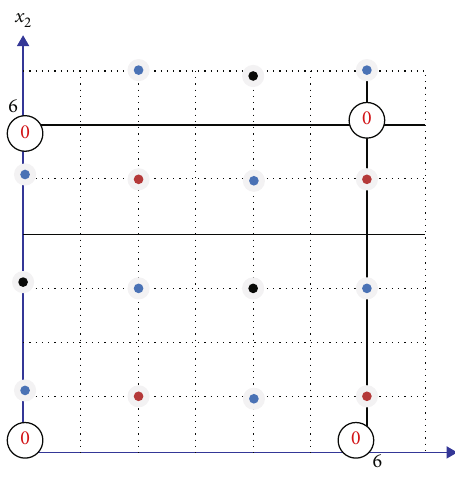
Figure 9: First generation of f